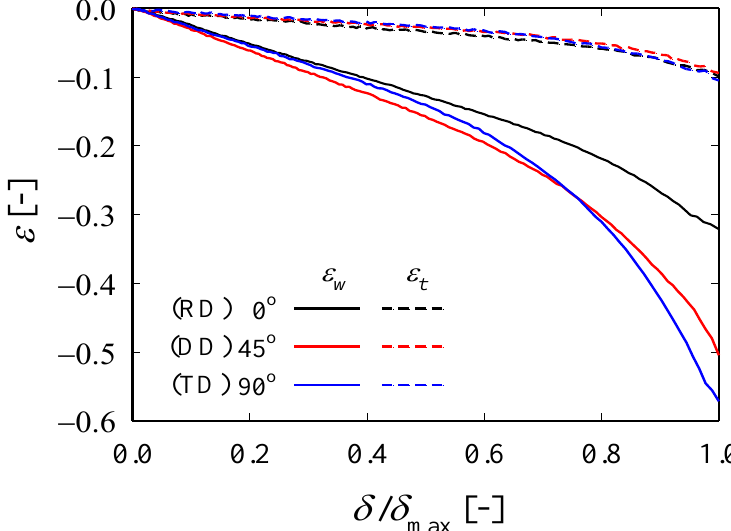
Figure 5. Comparison of the ratio of ε w and ε t for various location (RD specimen).